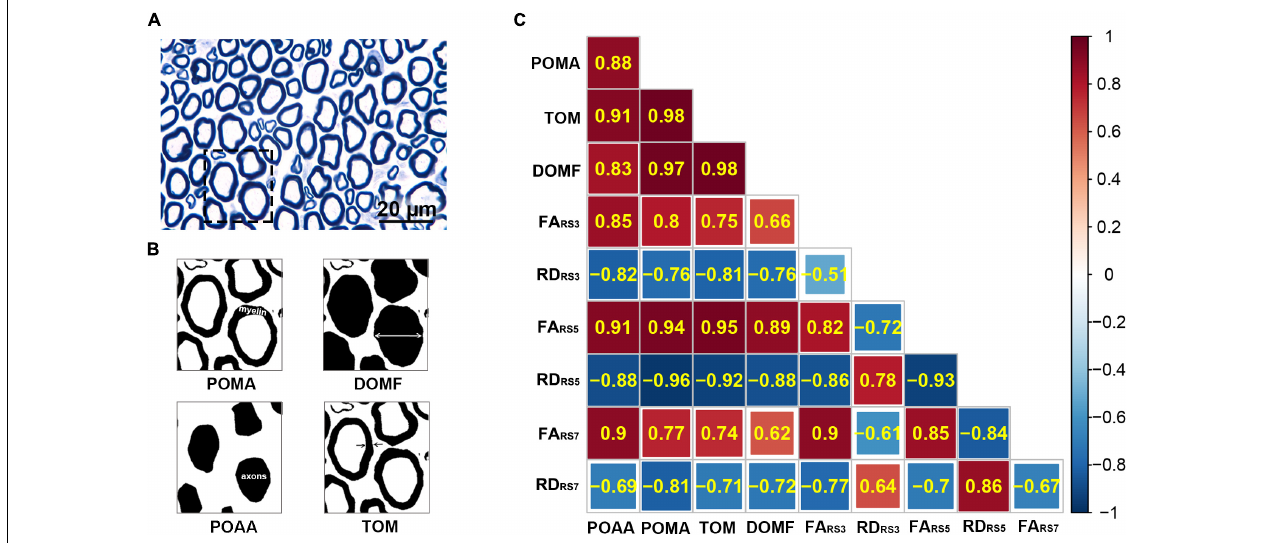
FIGURE 6 | Heatmap of correlation between DTI and histopathological parameters in RS3-EPI, RS5-EPI, and RS7-EPI. (A) Correlation coefficients between DTI parameters and histopathological parameters. (B) Toluidine blue myelin staining of the sciatic nerves ( × 1000). Scale: 20 µ m. (C) Toluidine blue myelin staining was analyzed by ImageJ software to determine the quantitative pathological parameters, including POAA, percentage of axon area; POMA, percentage of myelin area; TOM, the thickness of myelin; DOMF, diameter of myelinated fibers.